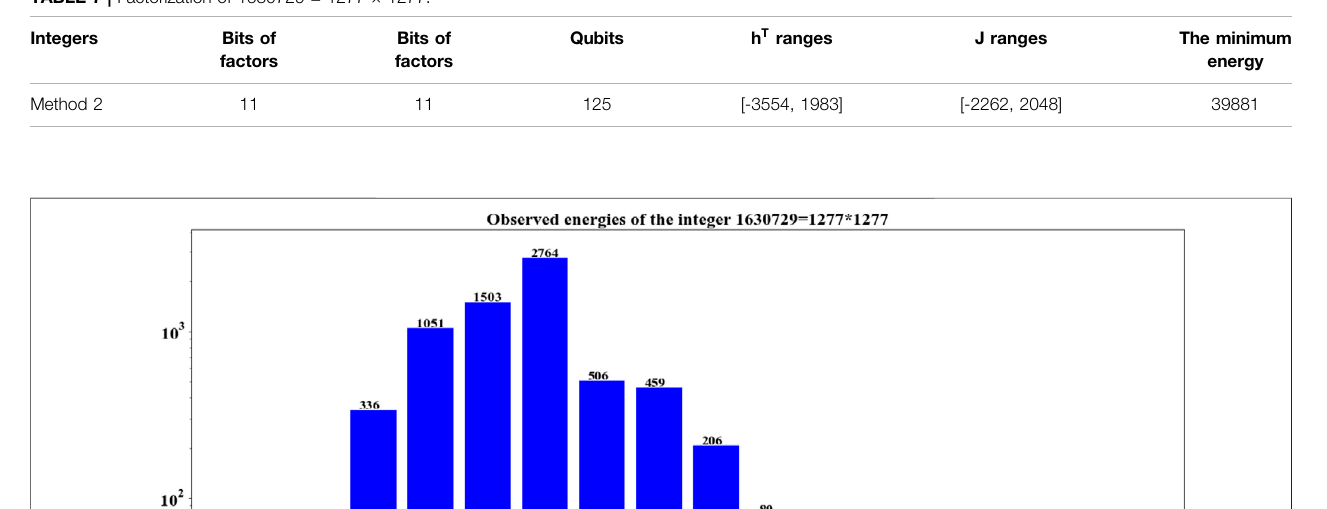
TABLE 7 | Factorization of 1630729 = 1277 × 1277.